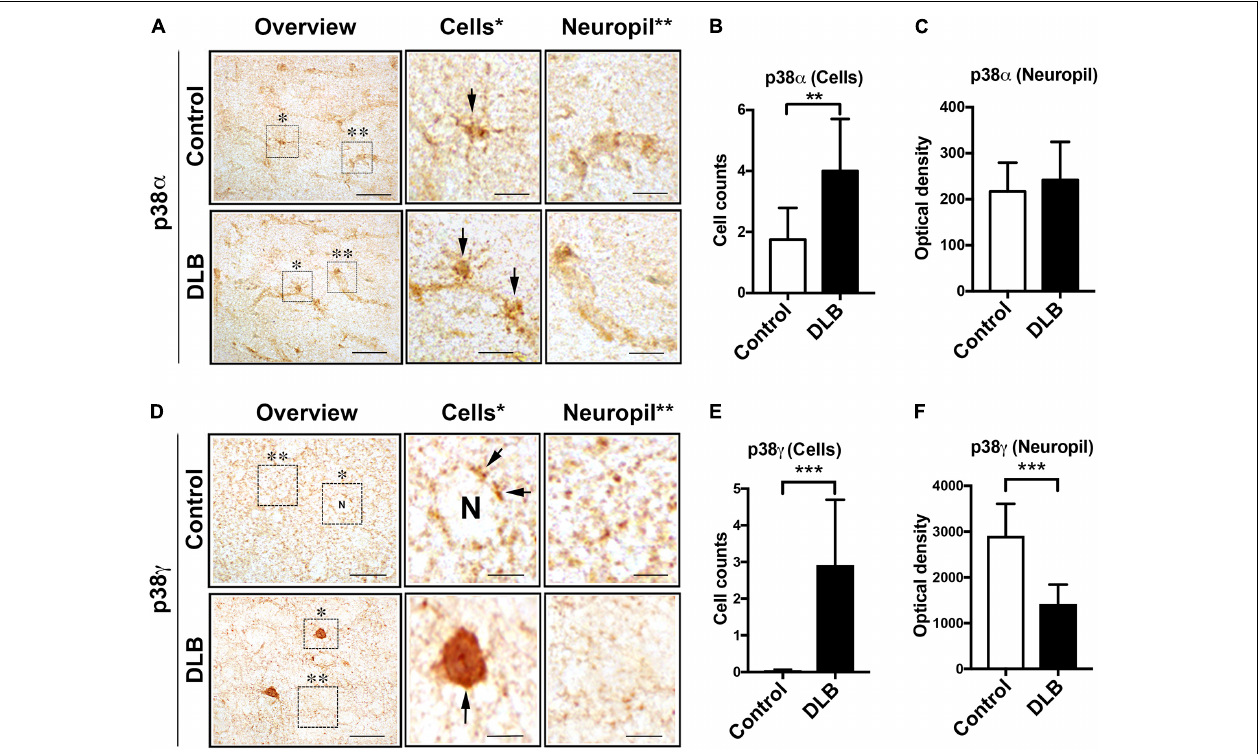
FIGURE 1 | Immunohistochemical analysis of the distribution of p38 α and p38 γ in DLB and control brains. Vibratome sections from the frontal cortex were immunolabeled with antibodies against p38 α and p38 γ and developed with DAB. (A) Left: representative low power bright field microscopic images (200 × ) (scale bar = 40 µ m) of human brains from healthy controls (top) and DLB patients (bottom) immunostained with a p38 α , middle: enlarged images (630 × ) of glial cells from the overview panel (*) (scale bar = 10 µ m), right: enlarged images (630 × ) of neuropil and blood vessels from the overview panel (**) (scale bar = 10 µ m). (B,C) Number of p38 α positive cells per 0.1 mm 2 and overall optical density of the neuropil. (D) Left: representative low power bright field microscopic images (200 × ) (scale bar = 40 µ m) of healthy controls (top) and DLB patients (bottom) immunostained with a p38 γ , middle: enlarged images (630 × ) of neuronal cells (represented as N in control) from the overview panel (*) (scale bar = 10 µ m), right: enlarged images (630 × ) of neuropil pre-synaptic terminals (**) (scale bar = 10 µ m). (E,F) Number of p38 γ positive cells per 0.1 mm 2 and overall optical density of the neuropil. n = 8 for control and n = 12 for DLB (** p < 0.05, *** p <